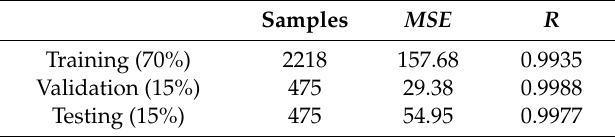
Table 4. Mean squared error and regression value of